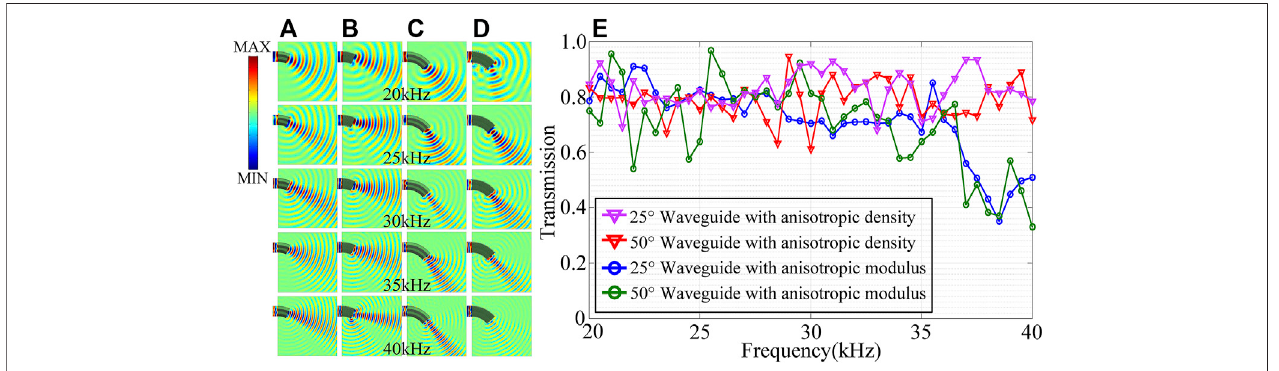
FIGURE 2 | Full-band pressure maps and the transmission ef fi ciencies of the four acoustic waveguides. (A) Anisotropic-density acoustic waveguide with the de fl ection angle of 25 ° . (B) Anisotropic-modulus acoustic waveguide with the de fl ection angle of 25 ° . (C) Anisotropic-density acoustic waveguide with the de fl ection angle of 50 ° . (D) Anisotropic-modulus acoustic waveguide with the de fl ection angle of 50 ° . (E) Transmission ef fi